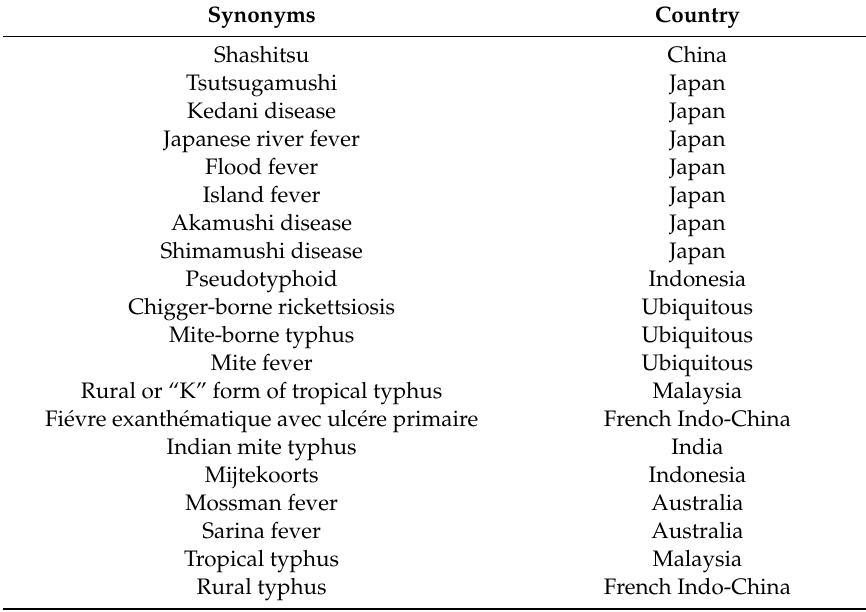
Table 2. Synonyms for Scrub